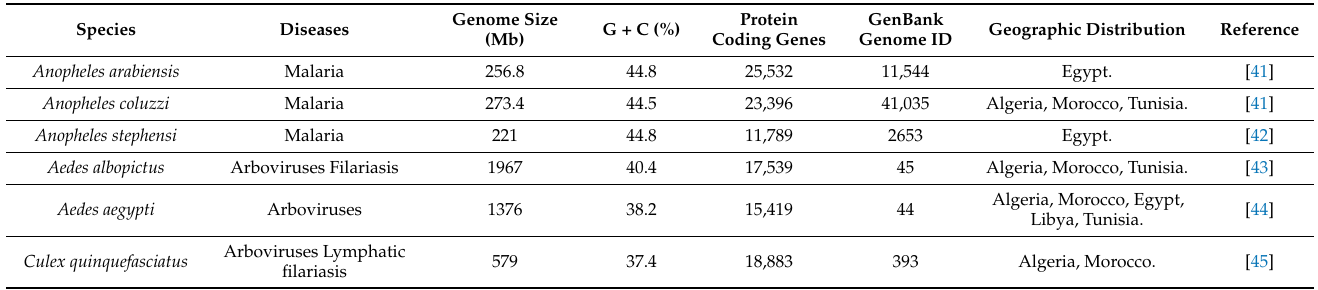
Table 1. Main characteristics of currently available mosquito vector species